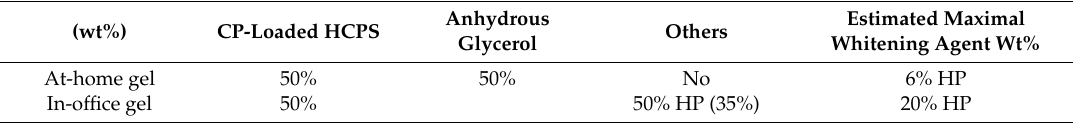
Table 1. The composition of at-home gel and in-office bleaching gel. CP: carbamide peroxide; HCPS: hollow calcium phosphate